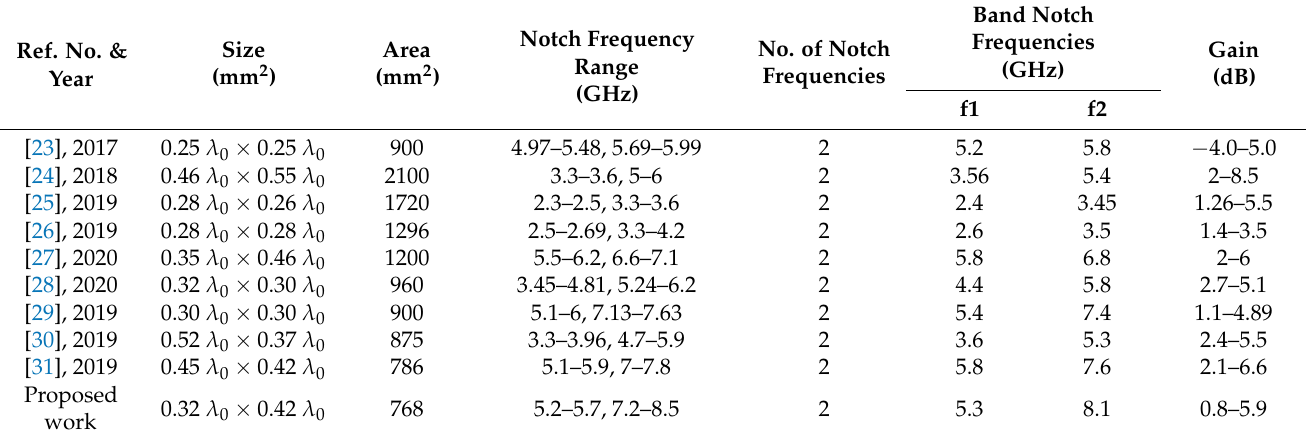
Table 2. Comparison of the proposed antenna with previous works.